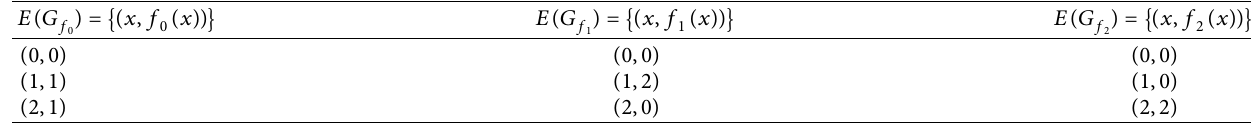
G G f 0 , f 1 , and f 2 for Example 5.